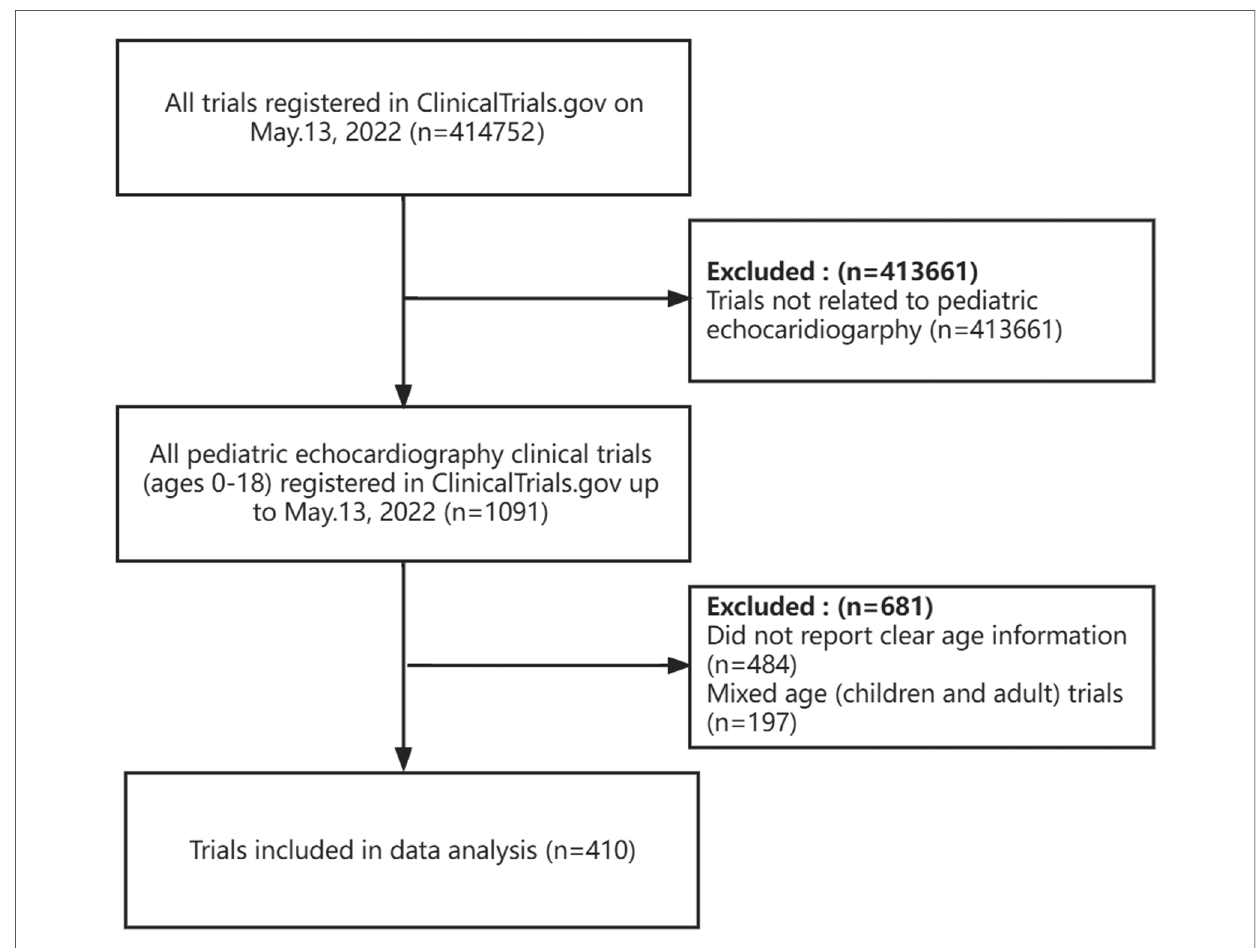
FIGURE 1 The fl ow chart of study clinical trials